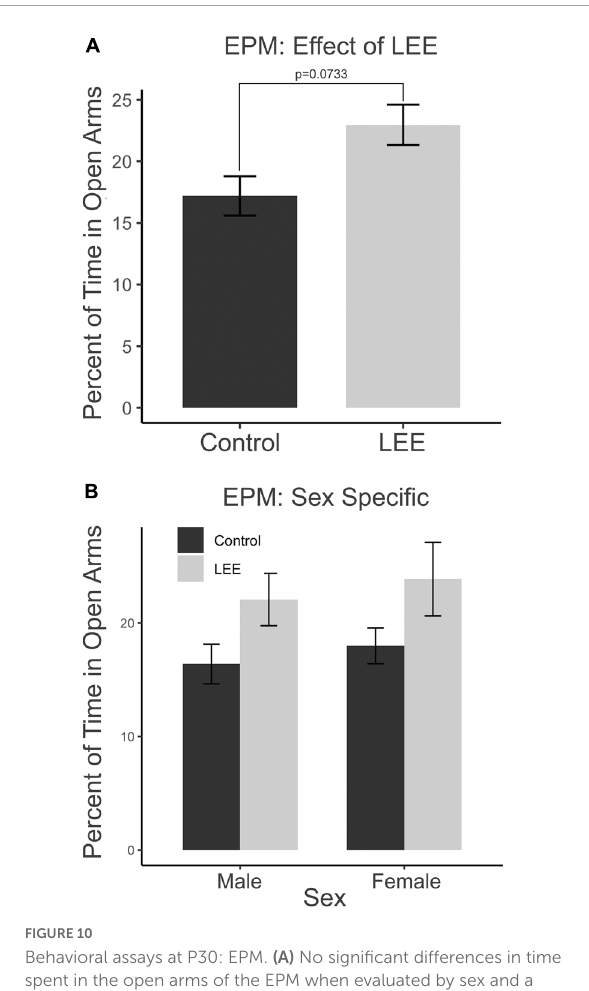
FIGURE10 Behavioral assays at P30: EPM. (A) No significant differences in time spent in the open arms of the EPM when evaluated by sex and a marginal effect of condition ( p = 0.07). (B) No effects observed in planned comparisons for male and female pups ( N = 41). Data expressed as mean ± SEM.